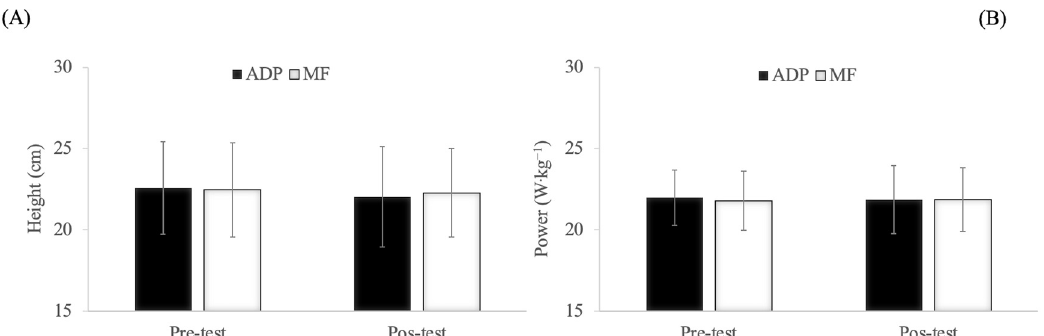
Figure 3. Muscular fatigue assessed by countermovement jump (CMJ) test before and after the aerobic dance classes. ( A ) Mean height (cm) in CMJ. ( B ) Mean power (W·kg − 1 ) in CMJ. No significant differences were detected among experimental conditions. Abbreviations used: ADP = air dissipation platform; MF = marble floor (hard surface).